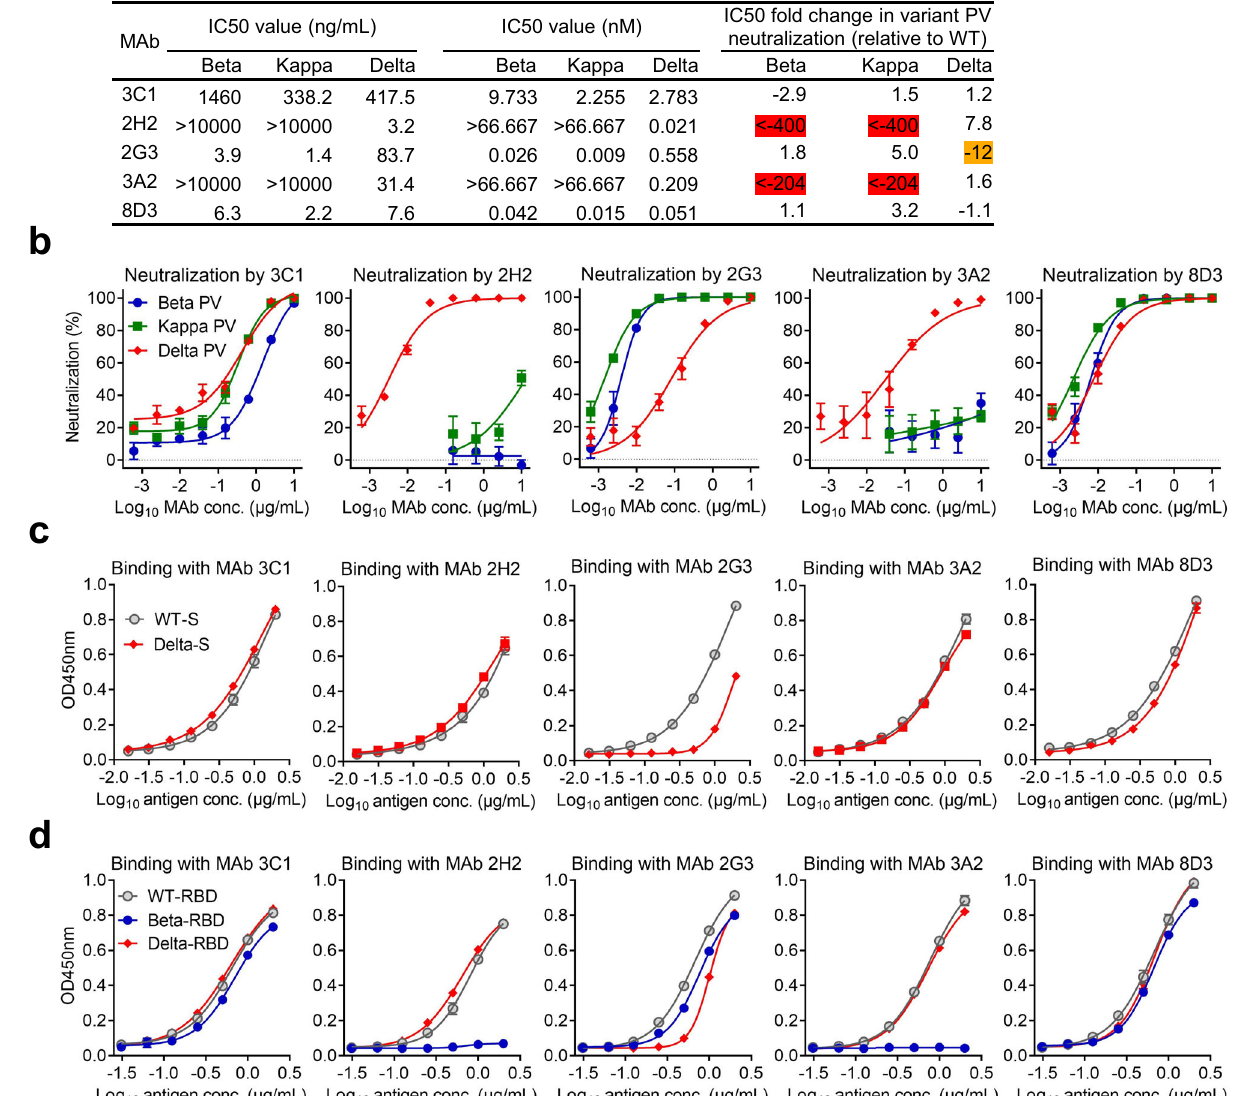
Fig. 4 Neutralization breadth and binding properties of the MAbs (3C1, 2H2, 2G3, 3A2, and 8D3) against SARS-CoV-2 variants. a Neutralization values and fold change in neutralization IC50 of the MAbs against the variant pseudoviruses, relative to the WT pseudovirus. A minus sign (-) denotes decrease. Orange shade, more than 10-fold decrease; red shade, more than 100-fold decrease. b Neutralization activity of the MAbs towards SARS-CoV-2 Beta, Kappa, and Delta variant pseudoviruses. The MAbs were serially diluted and tested for neutralization. Data are expressed as mean ± SEM of four replicate wells. c Binding properties of the MAbs with recombinant S trimers derived from the WT and Delta strains were determined by ELISA. Serial dilutions of S trimers were coated onto the wells. Data are expressed as mean ± SD of triplicate wells. d Binding properties of the MAbs with recombinant RBD proteins derived from the WT, Beta, and Delta strains were measured by ELISA. Serial dilutions of RBD were coated onto the wells. Data are expressed as mean ± SD of triplicate wells. Source data are provided as a Source Data fi